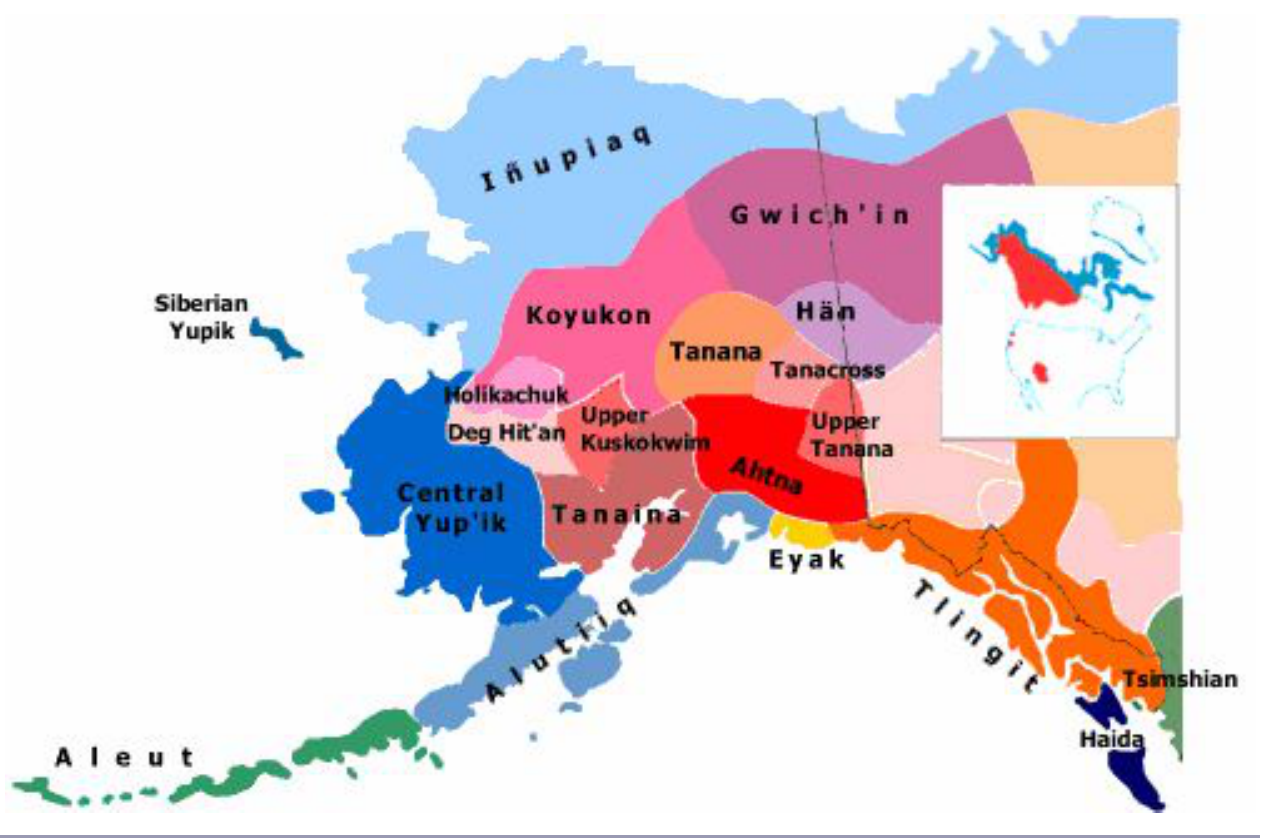
Fig. 1. Native peoples and languages of Alaska (Krauss